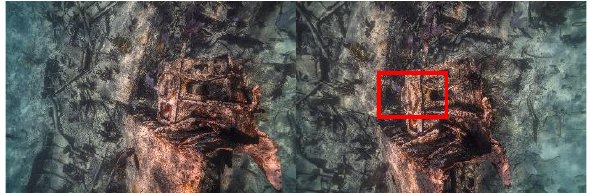
Figure 7. the stereo couple selected for testing different enhancement algorithms. In red, the portion of the image, representing the mast step, showed in figure